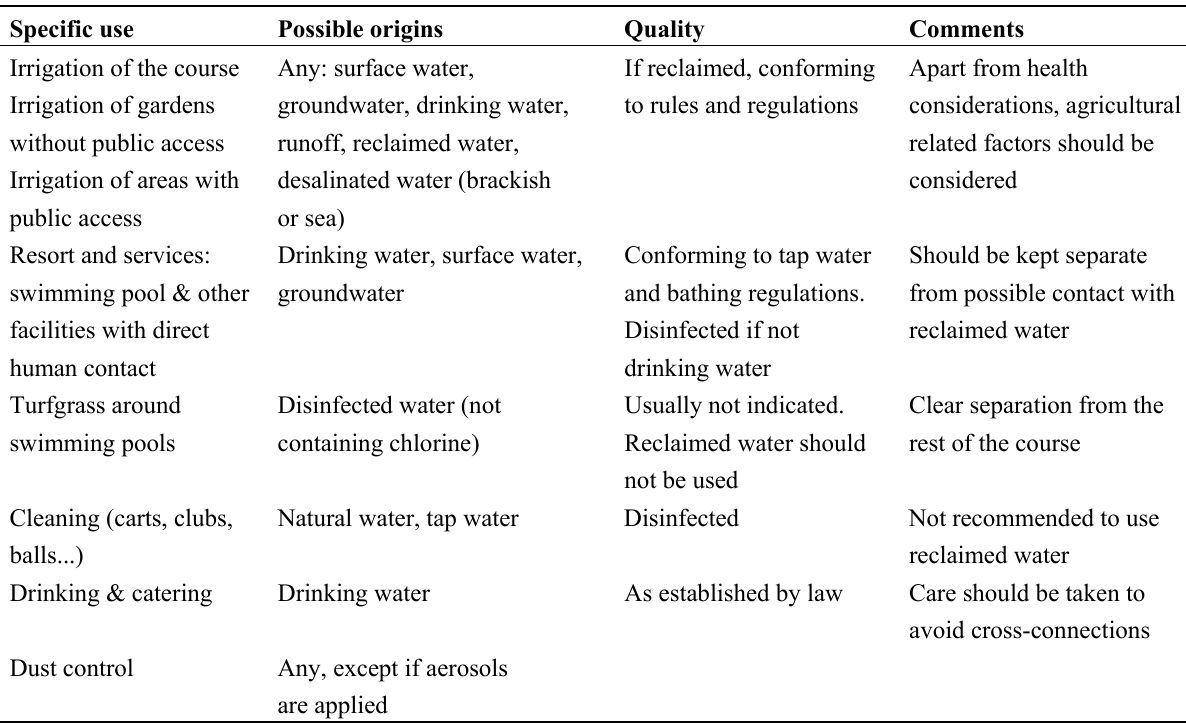
Table 3. Water employed on golf